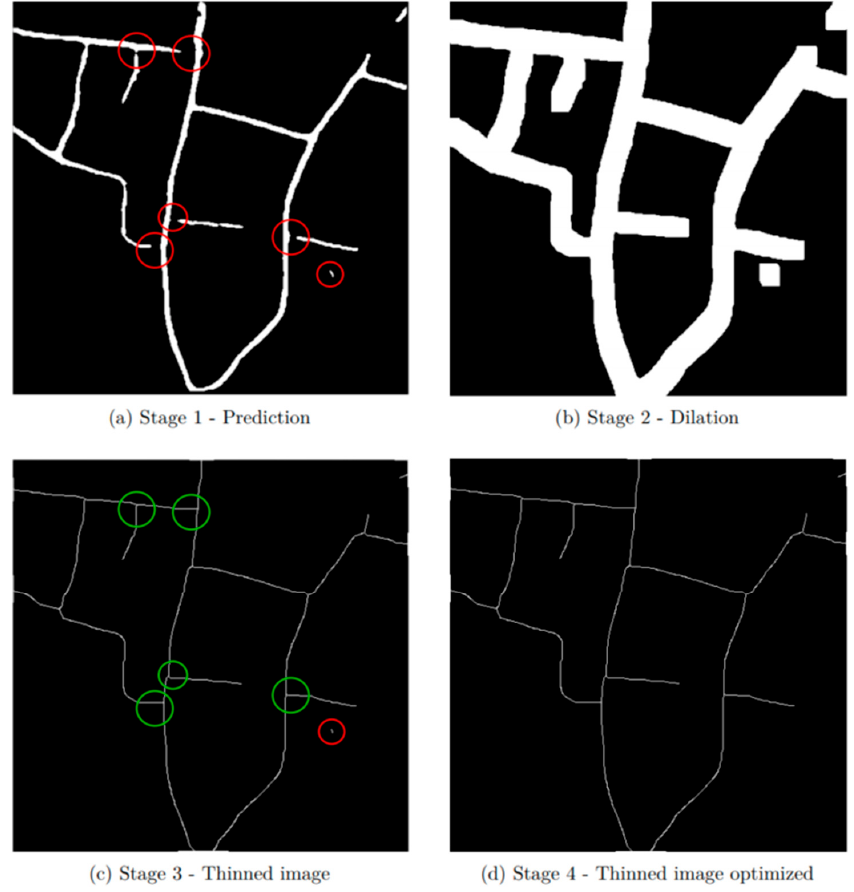
Figure 6. Sample results of road connection optimization process: ( a ) stage 1—prediction (red circles represent missing intersections and an artifact); ( b ) stage 2—dilation; ( c ) stage 3—thinning (the intersections in green circles have been corrected; the artifact in the red circle is going to be removed); ( d ) final results after removing smaller objects.